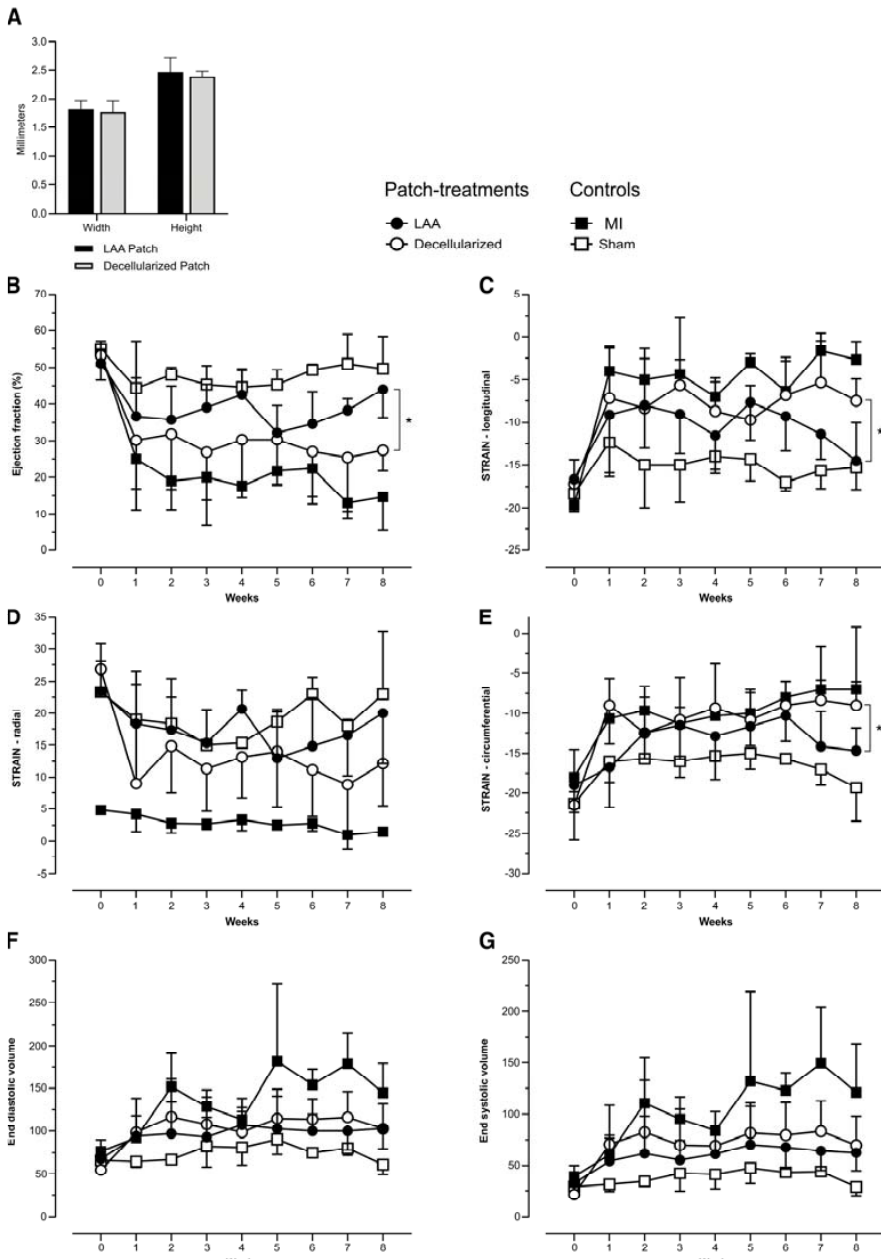
Figure 3. Patch comparisons and functional (echocardiography) follow ‐ up after the LAA transplantation. ( A ) Comparison of the widths and heights of LAA and decellularized patches. ( B ) Ejection fractions were similar at 2 weeks, but during the follow ‐ up, the difference between the two treatment groups increased, reaching a statistical significance at the 8w time point ( p = 0.02). ( C ) The longitudinal strain analysis (long axis) demonstrates similar characteristics of two treatment groups before and 2 weeks after MI, but their difference reaches a statistical significance at 7 weeks ( p = 0.03) and further increases at 8 weeks ( p = 0.01). ( D ) The radial strain analysis (longitudinal axis) demonstrates an increasing difference between the two treatment groups, but statistical significance was not reached. ( E ) The circumferential strain analysis (short axis) demonstrates results similar to longitudinal strain. Statistical significance is at 7 weeks ( p = 0.02) and at 8 weeks ( p = 0.01). ( F , G ) End ‐ diastolic and end ‐ systolic volumes at indicated times after MI. LAA patch ( n = 6), decellularized LAA patch ( n = 6), MI ( n = 3), and Sham ( n = 3). * p < 0.05.